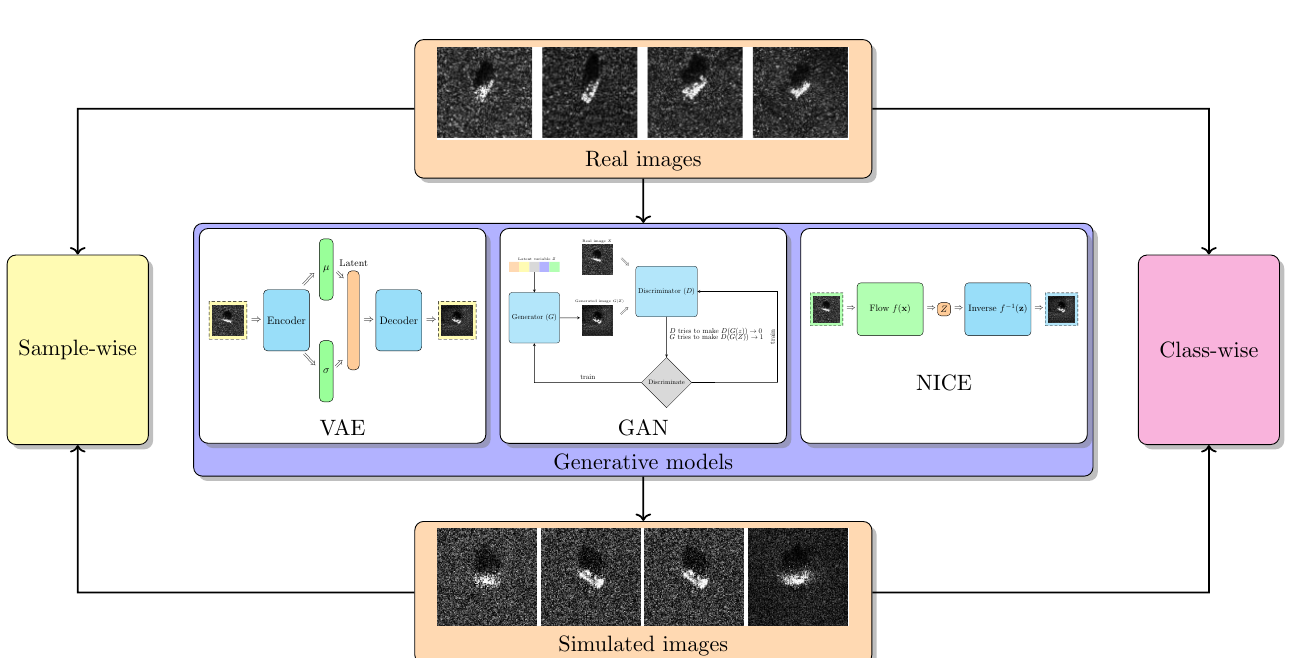
Figure 2. Summary of work in this